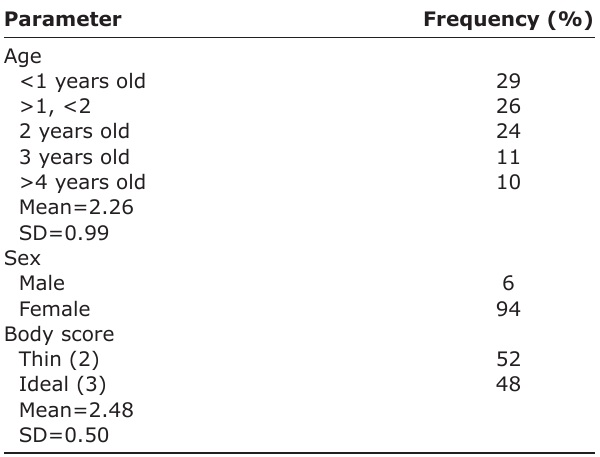
Table-2: Profile of selected goats in Cebu, the Philippines (n=100).